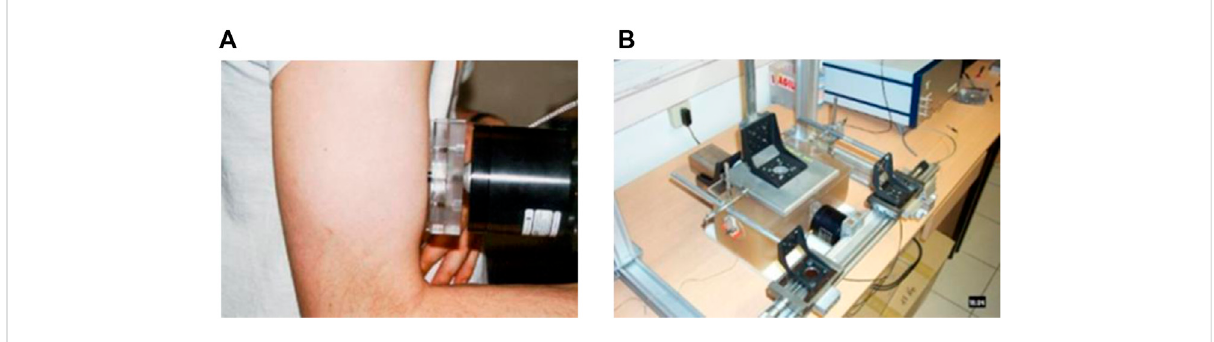
FIGURE 1 (A) 1D shearelasticityprobe applied invivo on the biceps brachii toquantify stiffnessanisotropybyrotatingtherod fi xedonthemini-shaker. (B) Apparent anisotropy quanti fi ed with two 1D shear elasticity probe in an acoustoelasticity experiment on agar-gelatin